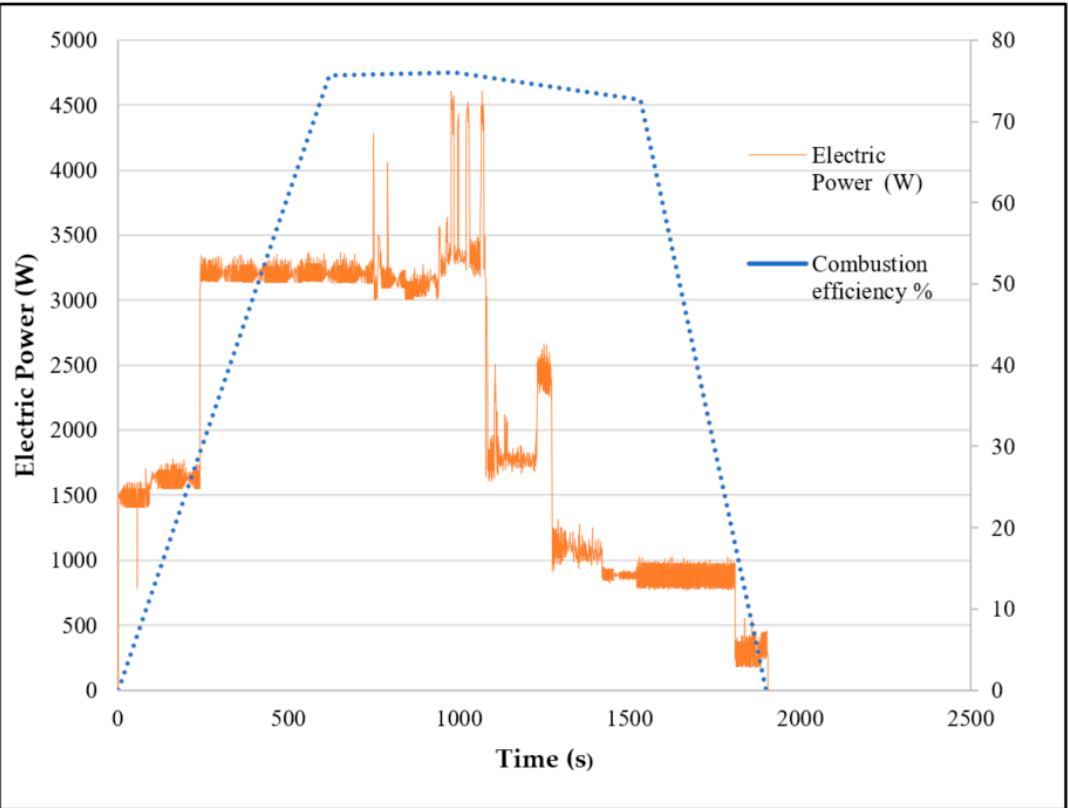
ffi ciency of a electric generator.